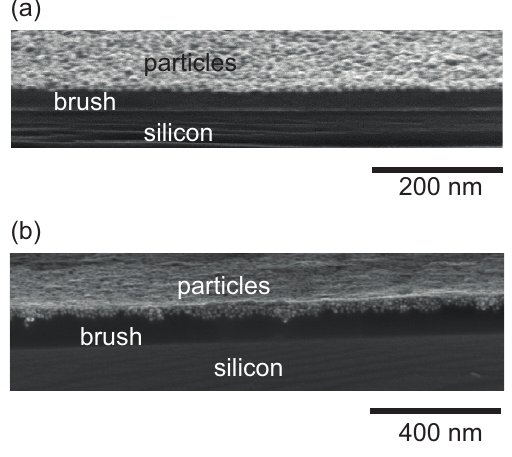
Figure 6. SEM cross-section images of the PDMAEMA/AuNP-13 hybrid with a ( a ) 60 nm and ( b ) a 200 nm thickness measured at 80 ◦ sample